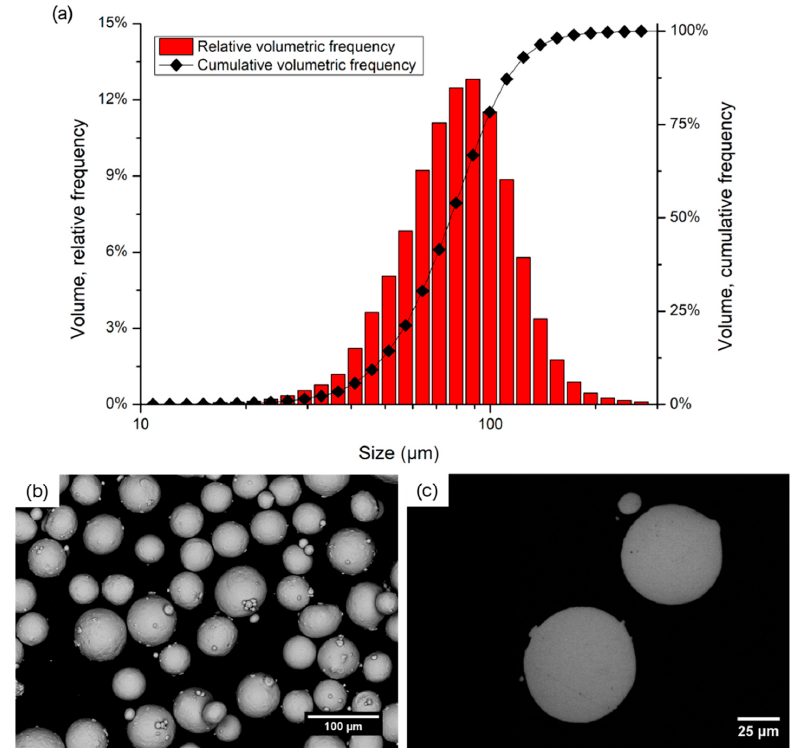
Figure 1. Particle size distribution of the Ti-6Al-4V ELI powder used for deposition ( a ), SEM image of the powder ( b ) and cross-section of the particles ( c